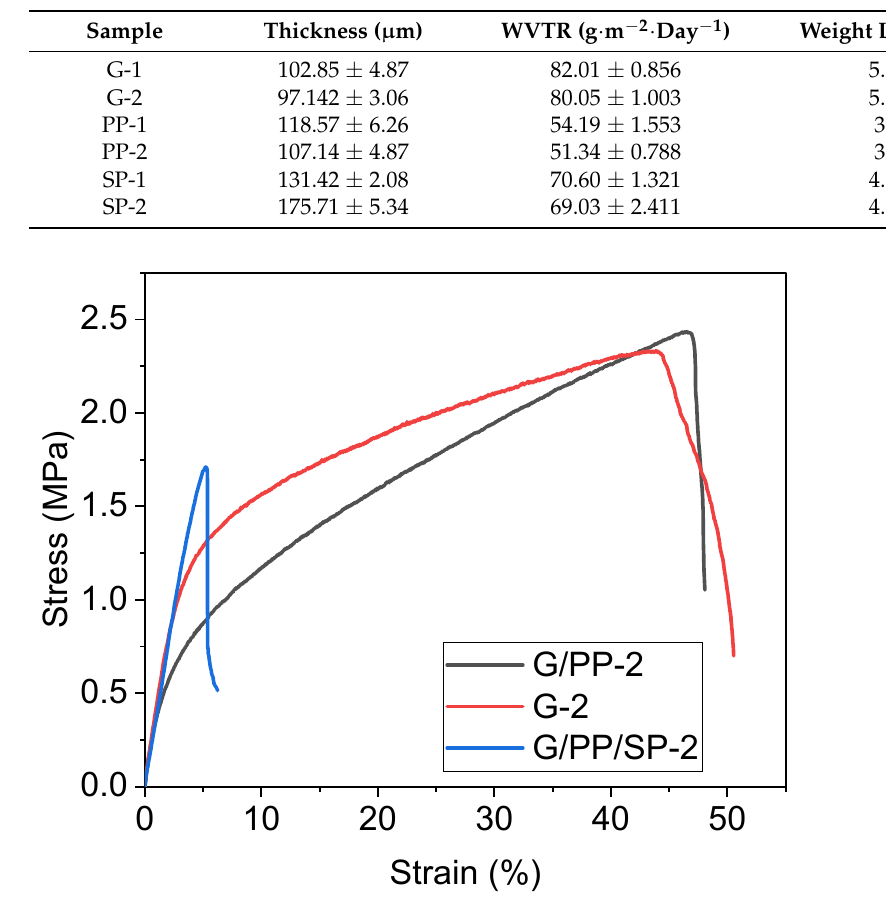
Figure 6. Stress–strain diagram of edible film with different concentration of gelatin (red line), papaya (black line), and soy protein (blue line).